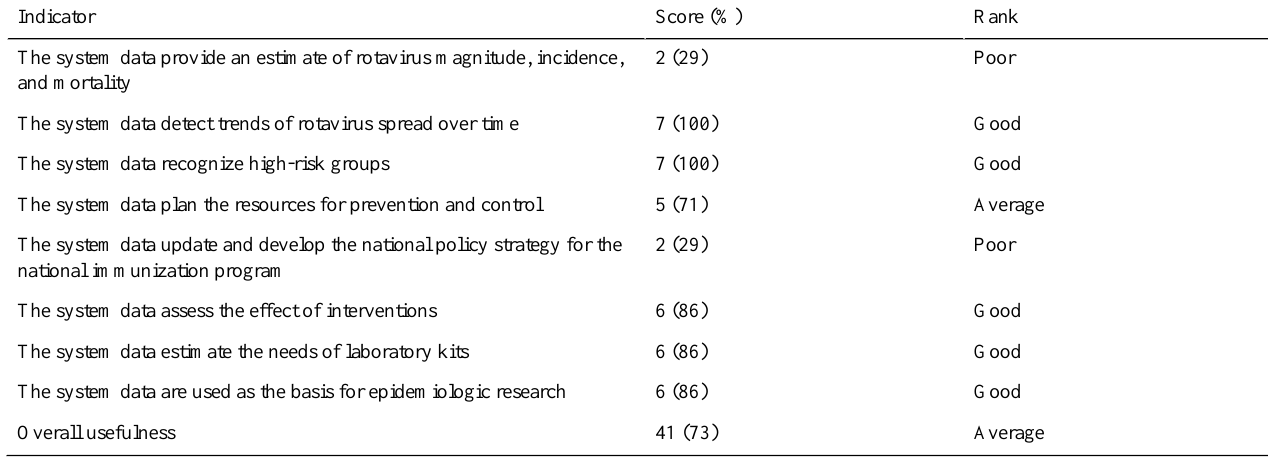
Table 1. The scores (score percent, %) and rank of the usefulness indicators as assessed by the central-level stakeholders.